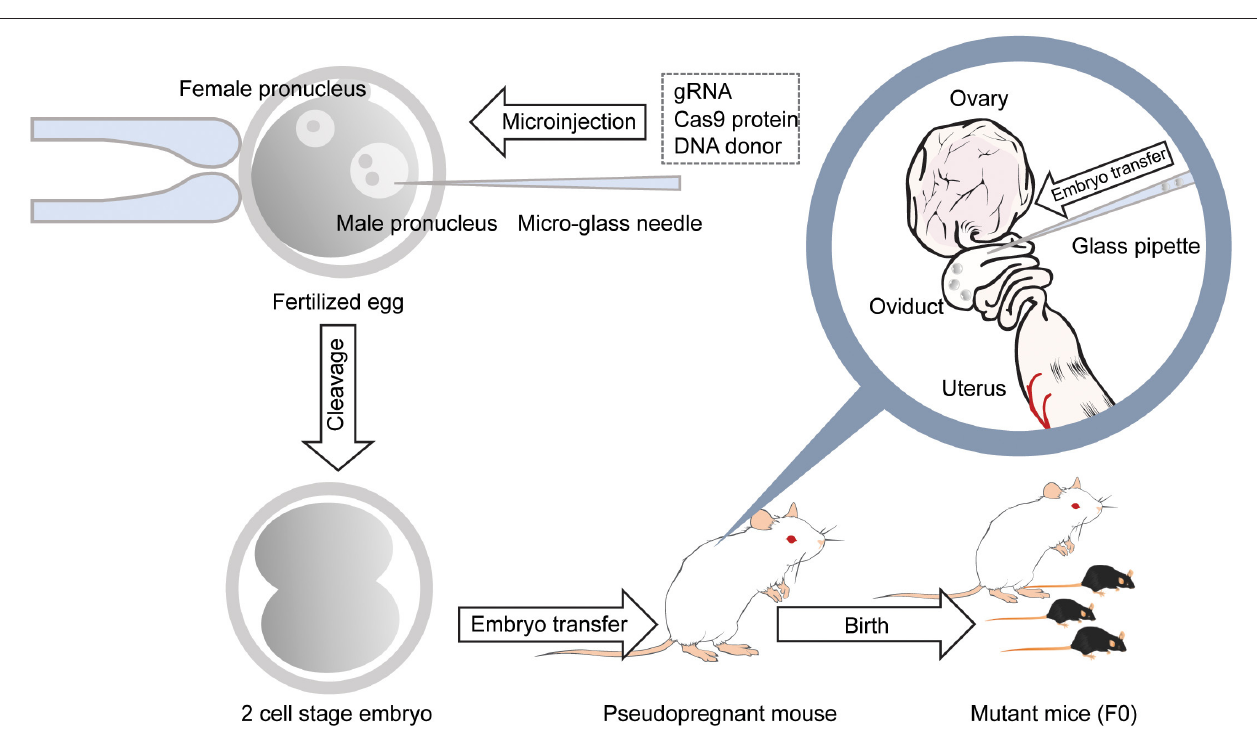
FIGURE 2 | Generation of gene-modified mice using CRISPR/Cas9 by microinjection. With a micro-glass needle, gRNA and Cas9 protein are injected into the male pronucleus of mouse embryos. DNA donors are also injected into the pronucleus when generating knockin mice. Embryos developed at the 2-cell stage the next day are transferred into the oviducts of the pseudopregnant female mouse, and 18–20 days later, F0 mice are born.